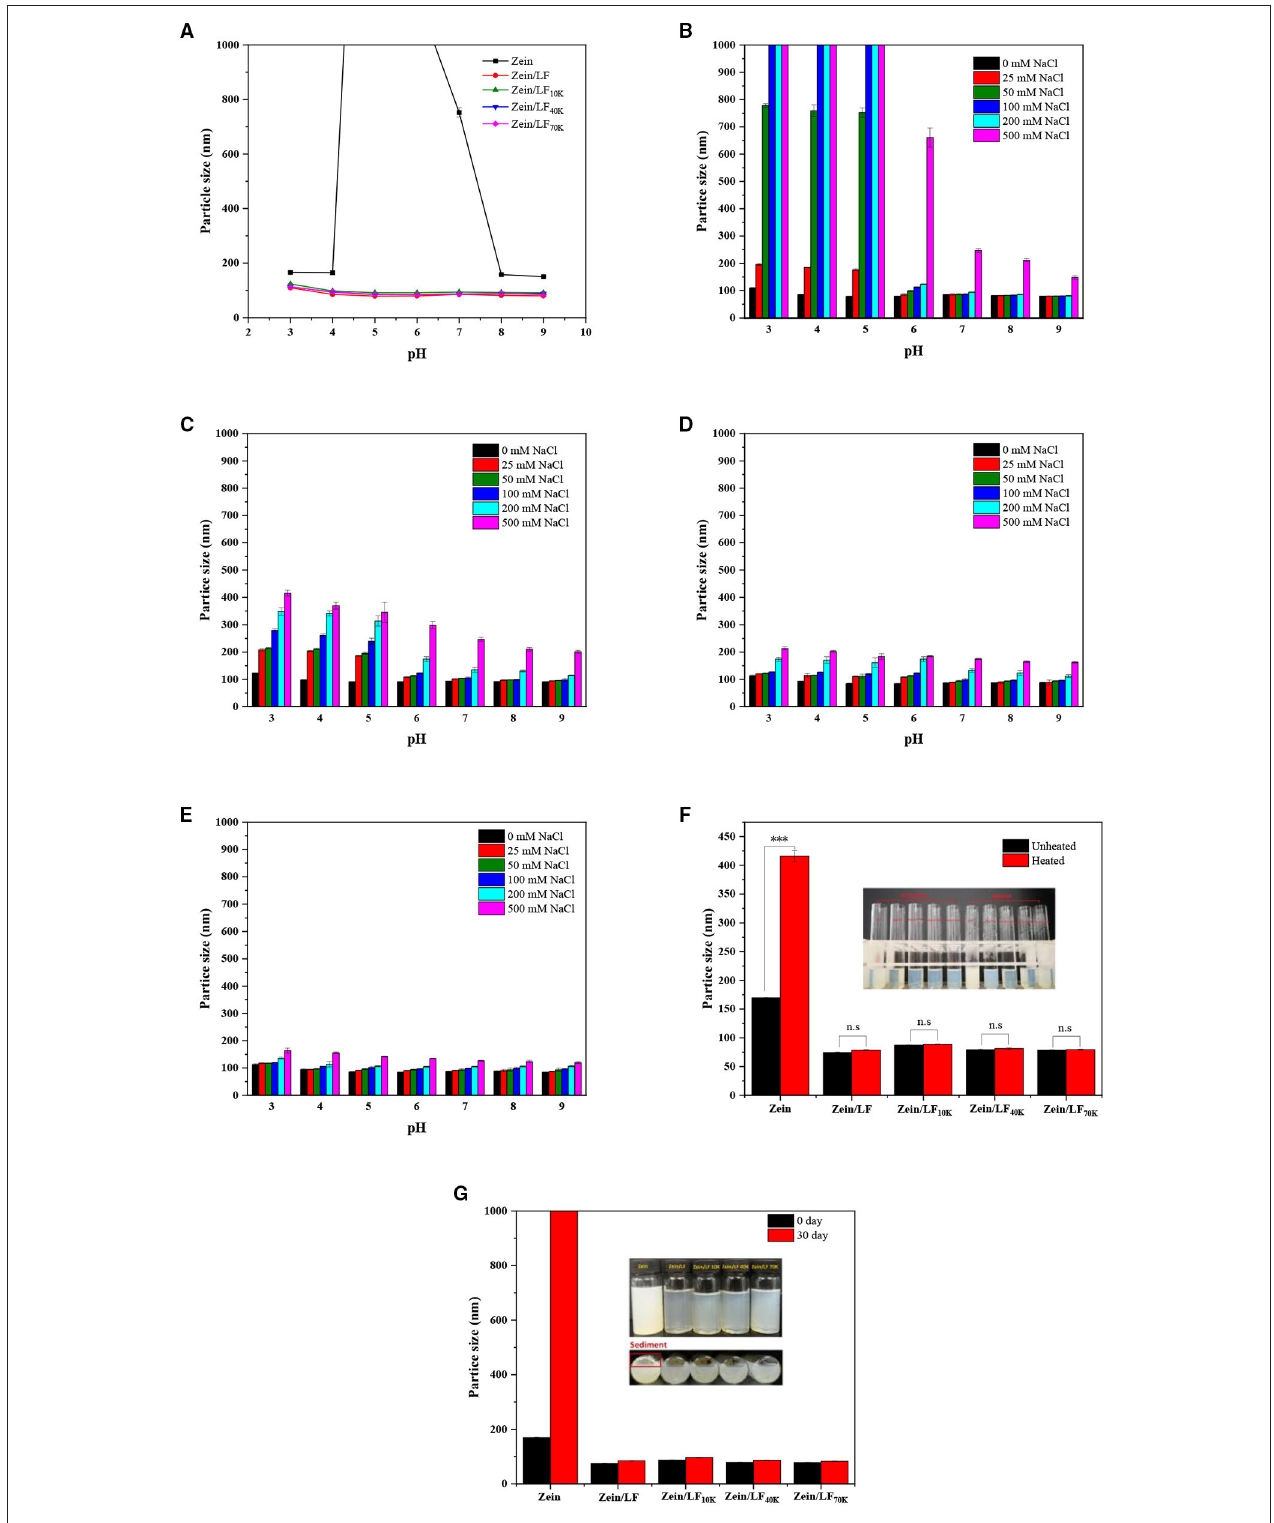
FIGURE 2 | Particle size of colloidal particles at pH 3-9 condition (A) . Particle size of colloidal particles under 0-500mM NaCl concentrations at pH 3-9 condition, zein/LF (B) , zein/LF 10K (C) , zein/LF 40K (D) , zein/LF 70K (E) . Particle size of colloidal particles under thermal treatments (F) . Particle size of colloidal particles in 1-month storage at 25 ◦ C (G)